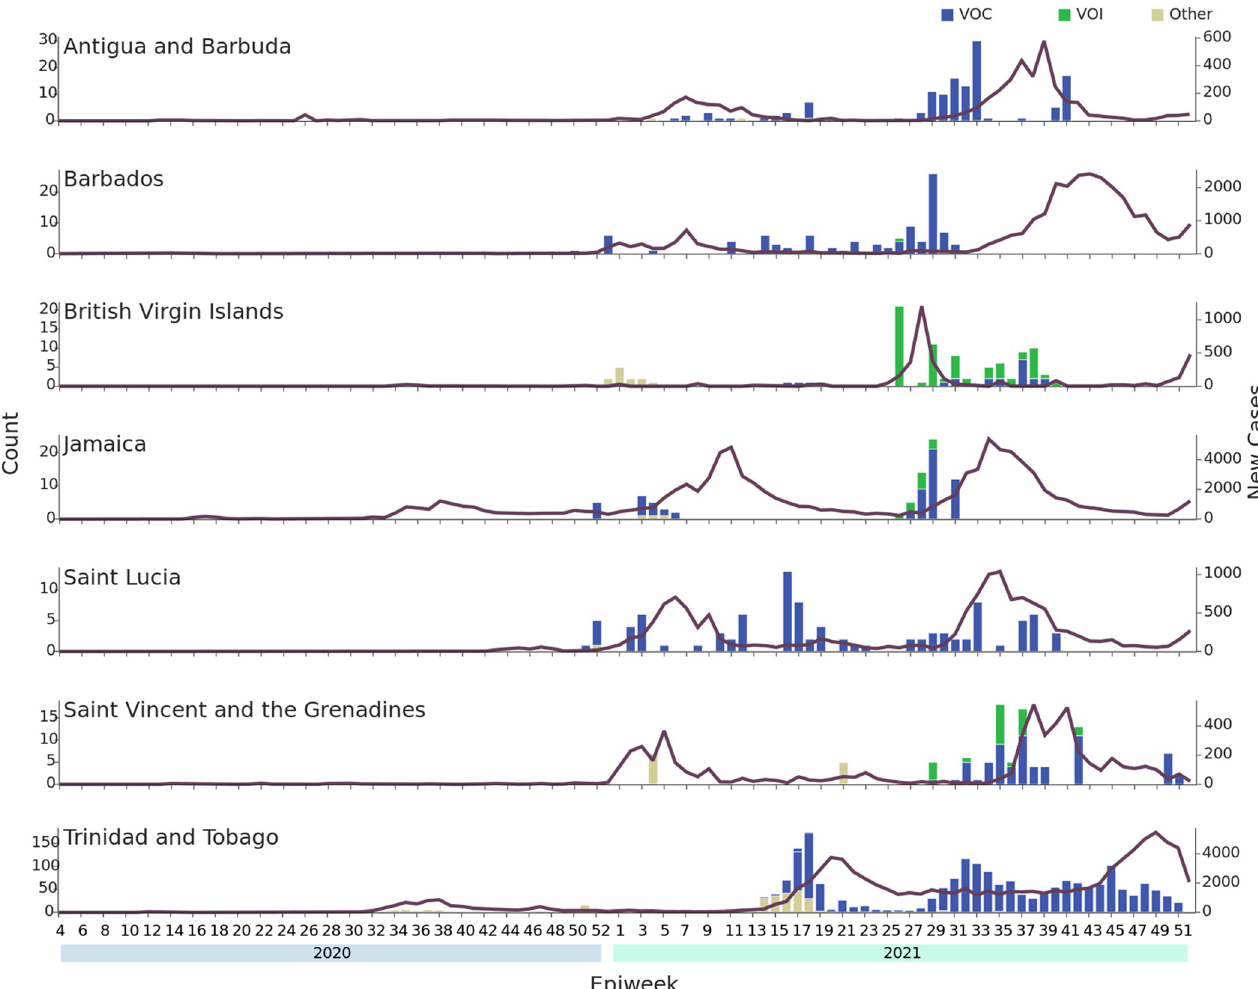
Fig 4. Frequency of variants of concern and interest identified by the COVID-19 IMPACT sequencing laboratory per epidemiological week for those CMS with at least 75 samples sequenced. Each histogram shows the number of VOCs (indicated in blue) and VOIs (indicated in green) per week in each CMS. All other lineages are grouped together as “Other” (yellow). Unsuccessfully sequenced samples are not represented as sufficient genome coverage was not obtained to be able to assign a Pango lineage. The purple line represents the number of confirmed reported COVID-19 cases for the country per week based on data available from The Johns Hopkins University Center for Systems Science and Engineering COVID-19 Data Repository. CMS = CARPHA member states. VOC = Variants of Concern. VOI = Variants of